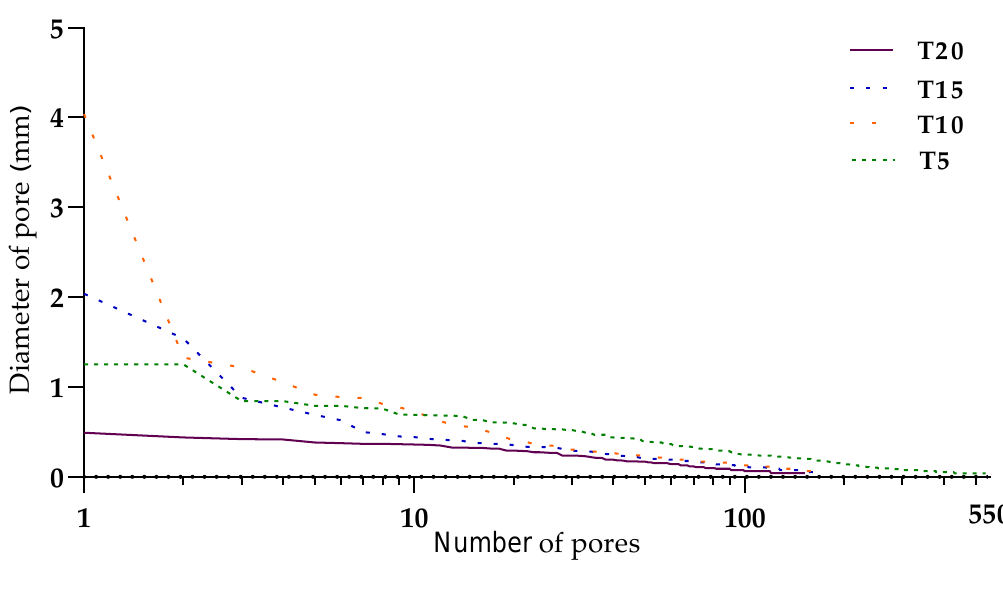
Figure 15. Pore distributions at the interface area based on cross-sectional CT scans, which can be found in more detail in Table 6.